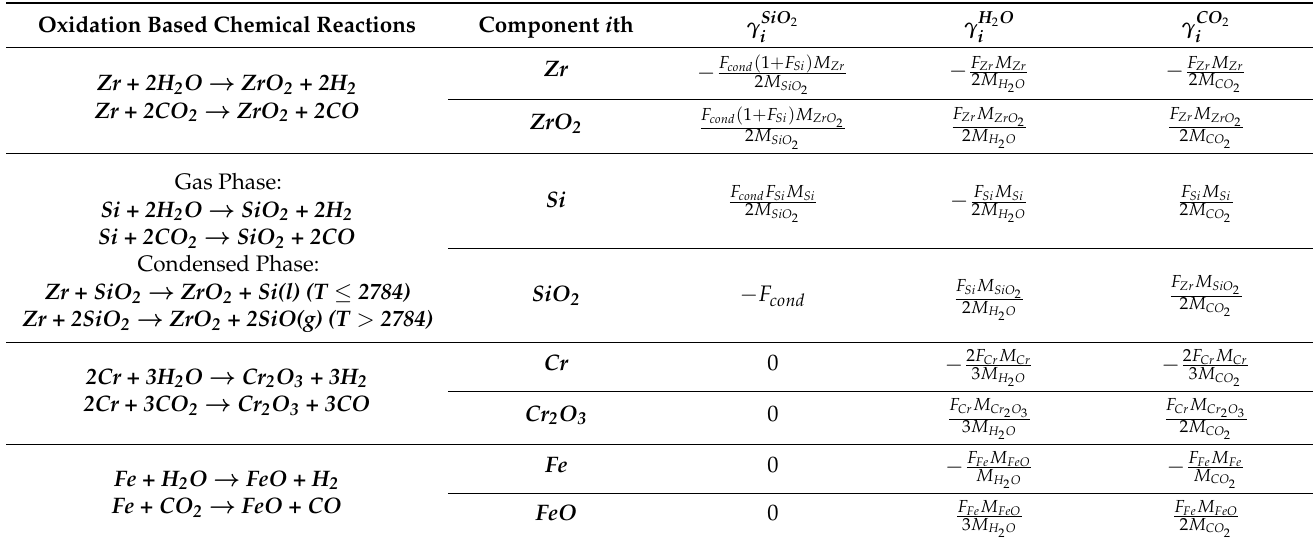
Table 1. Thermochemical reactions applied in